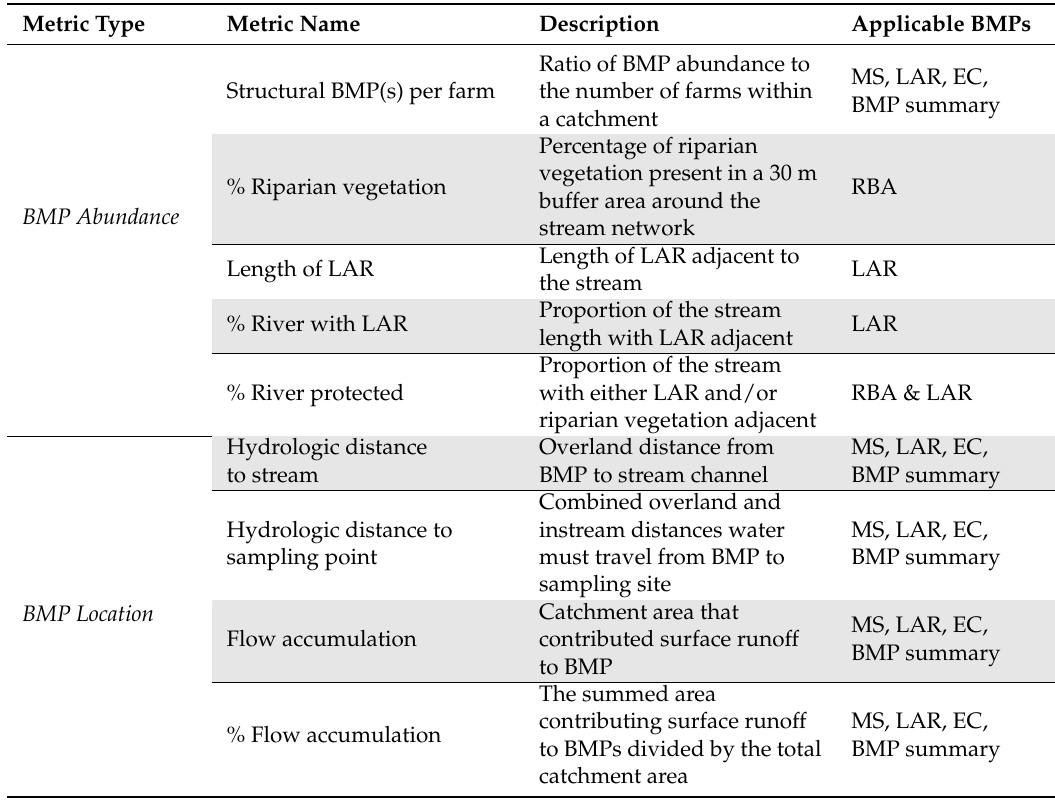
Table 2. BMP metrics and associated descriptions used to quantify abundance and location of agricultural BMPs in small catchments in southern